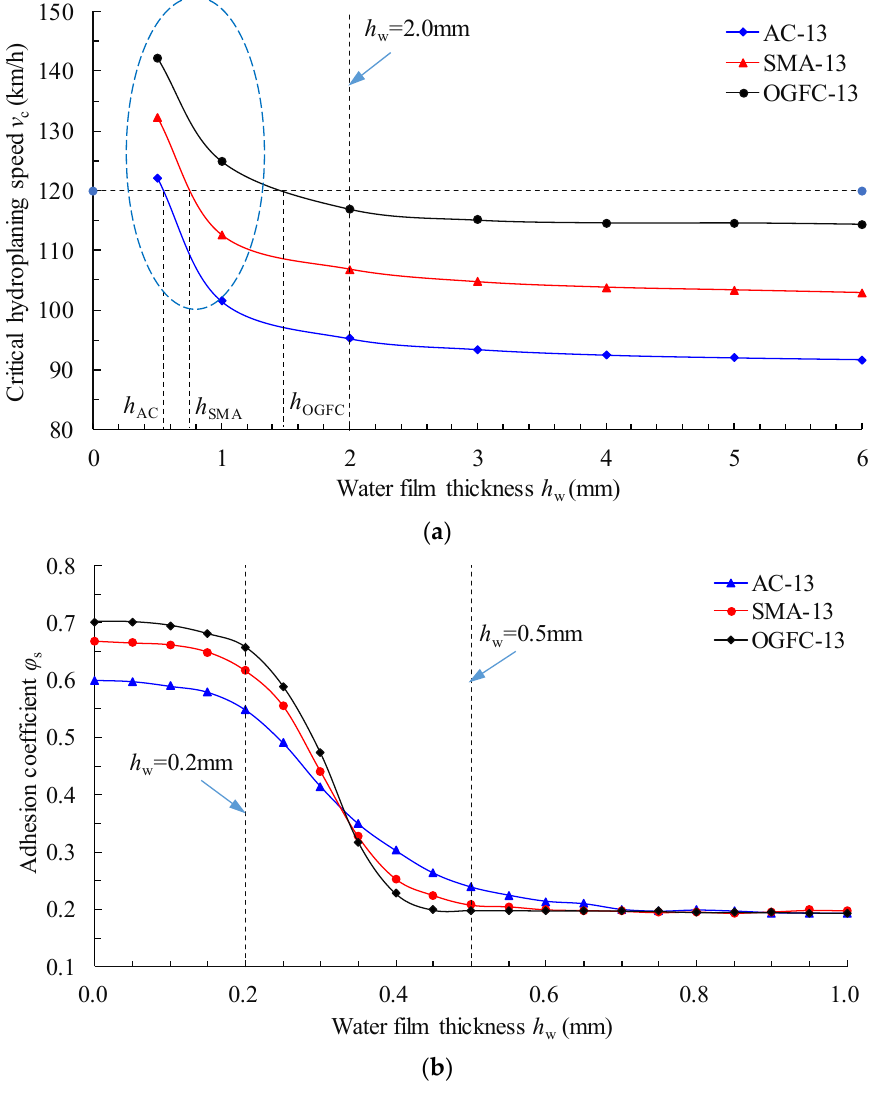
Figure 7. Influence of water film thickness on tire–pavement contact characteristics: ( a ) critical hydroplaning speed of the tire; ( b ) adhesion coefficient between tire and pavement.